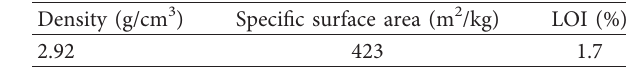
Table 1: Properties of